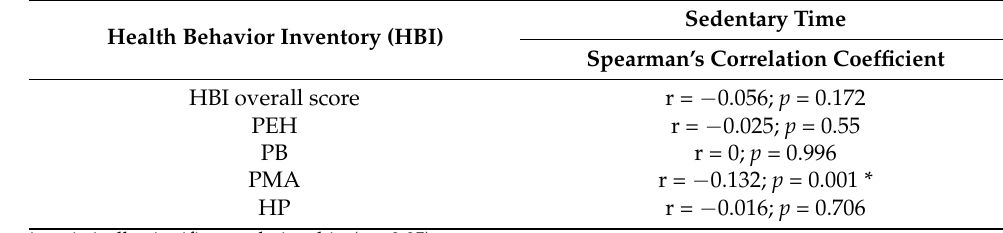
Table 8. Correlation between sedentary time and the level of health